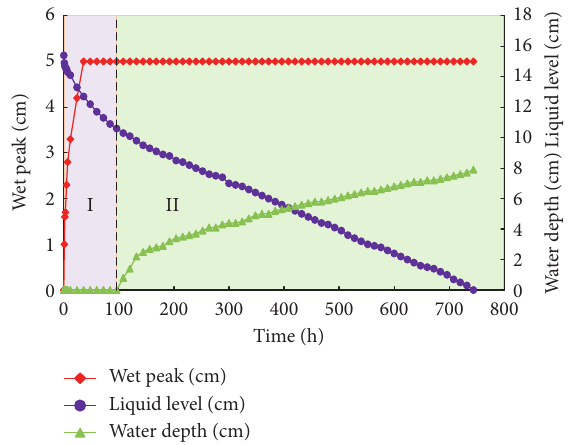
Figure 9: Demonstration of seepage experiment stage.